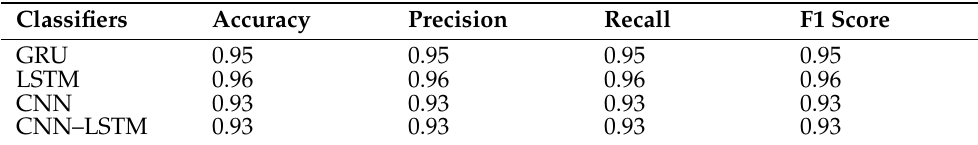
Table 16. Experimental results of Deep learning models using TextBlob sentiments.